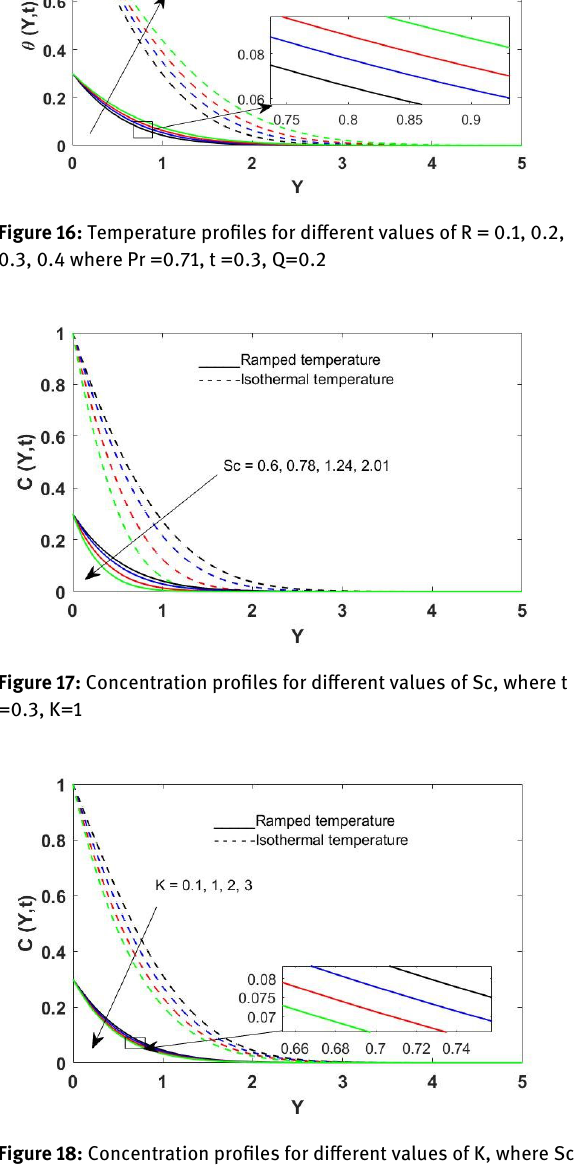
Figure 18: Concentration profiles for different values of K, where Sc =0.60, t